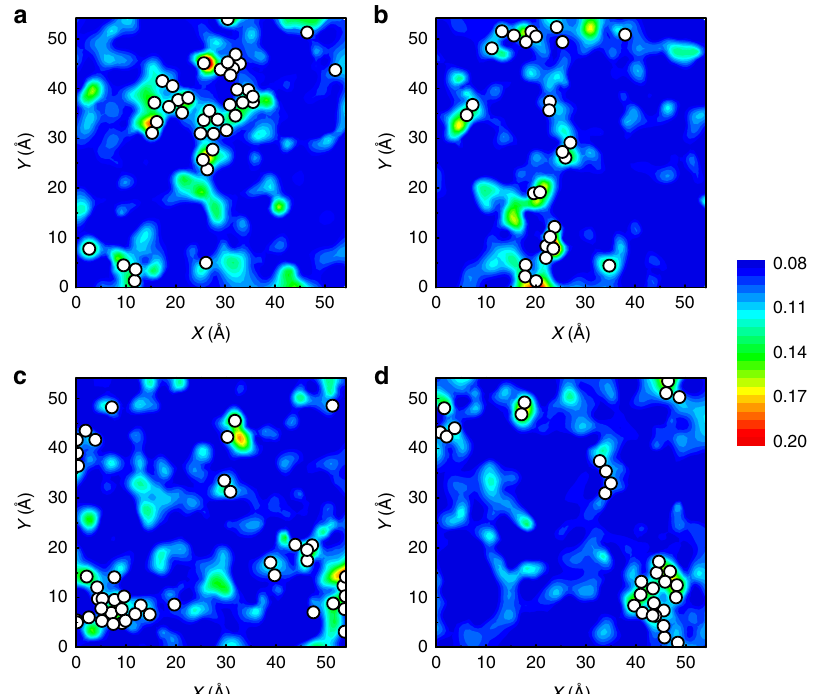
Figure 5 | Strong correlation between t flex, i and shear transformations. Contoured maps show the spatial distribution of flexibility volume u flex, i (see sidebar) in the Cu 64 Zr 36 metallic glass (Sample G28). Four slabs ( a – d ) are sampled for illustration purposes and each has a thickness of 2.5Å. White spots superimposed in the maps mark the locations of atoms that have experienced the most (top 5%) accumulative non-affine displacement ( D 2 min ), upon athermal quasi-static shear of the simulation box to a global strain of 5%. Note that not all such regions would undergo shear transformation for a particular loading. This is reasonable because apart from the intrinsic flexibility of the local configurations, the stress field (tensor) is another (extrinsic) factor that will influence the response of the